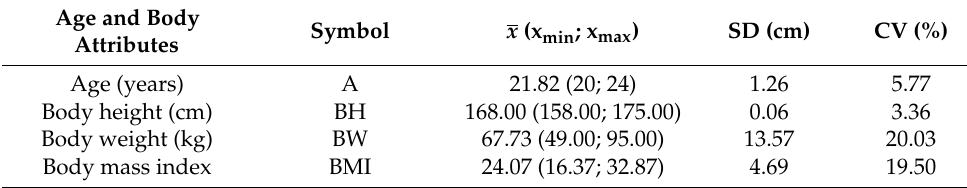
Table 1. Basic data of the measured